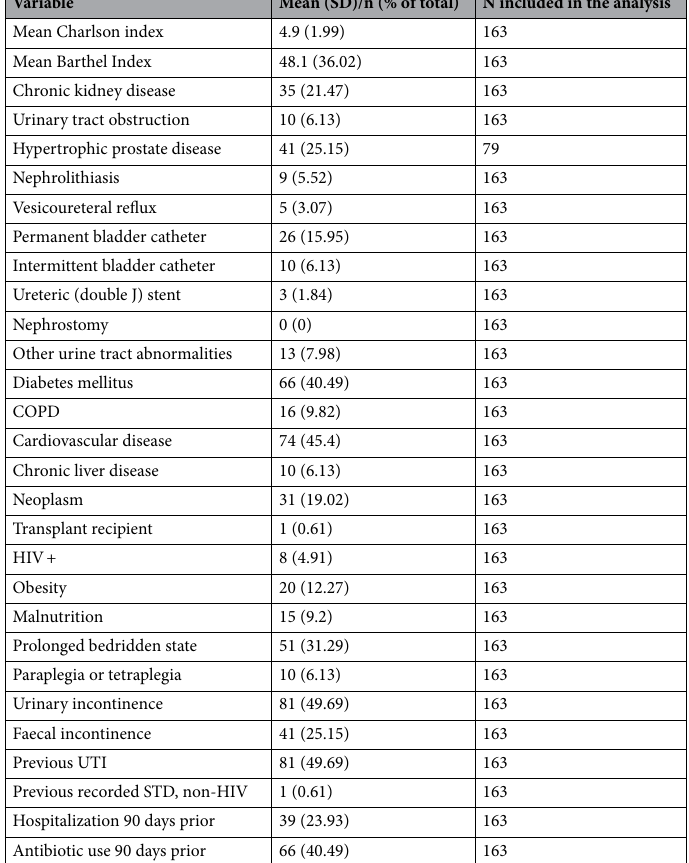
Table 1. Population